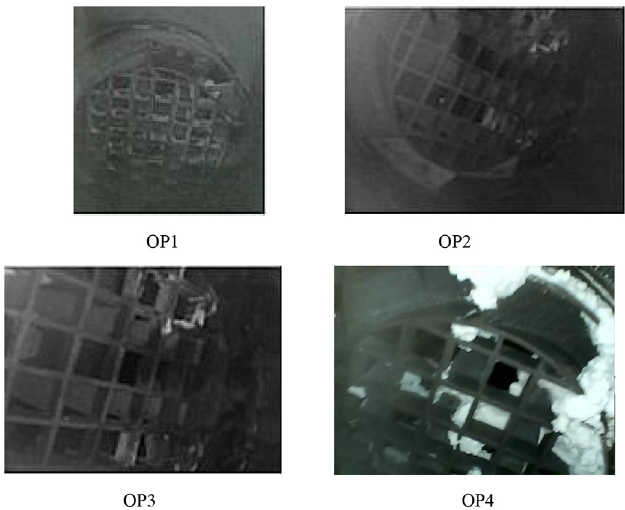
Fig. 17. Crystallization experiment.